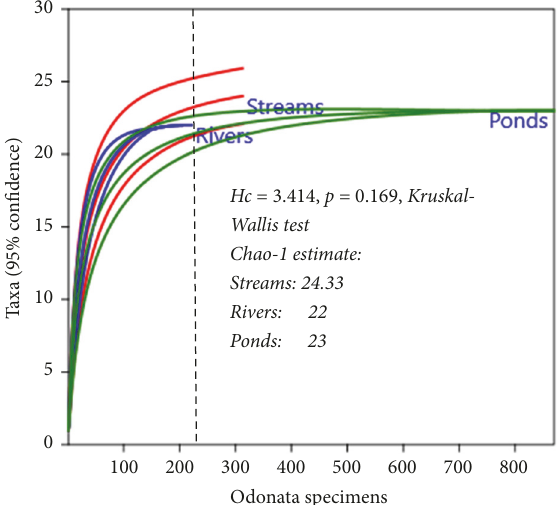
Hc = 3.414, p = 0.169, Kruskal- Wallis test Chao-1 estimate: